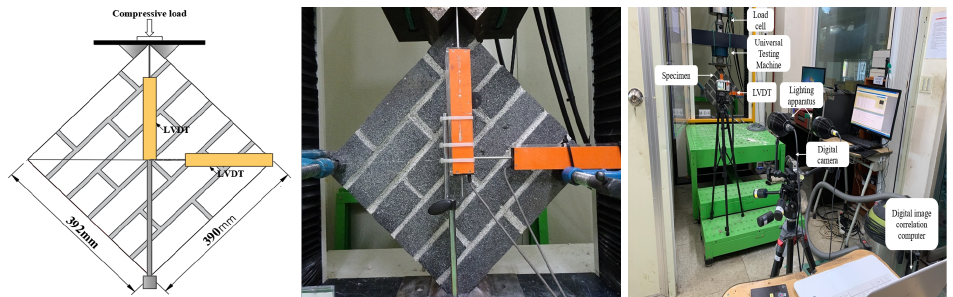
Figure 8. Experimental setups for Diagonal compression.